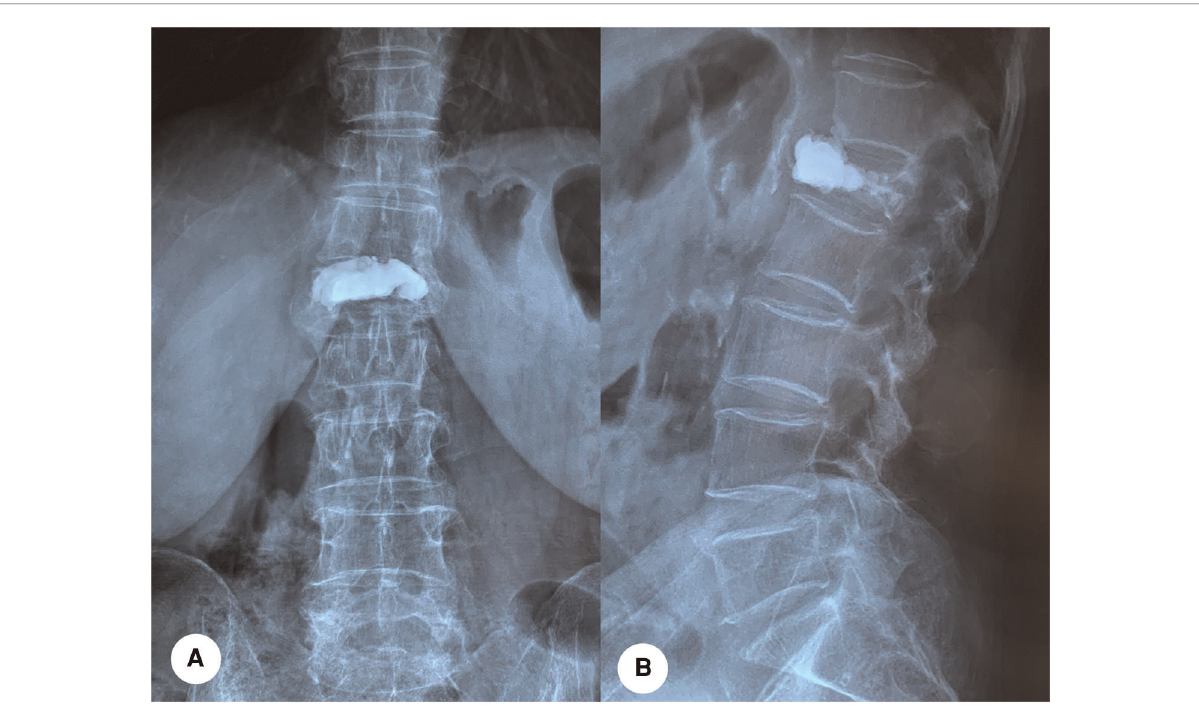
FIGURE 1 A 79-year-old female with bone cement displacement. ( A,B ): Anteroposterior and lateral x-ray radiographs showed that anterior displacement of bone cement of the L1